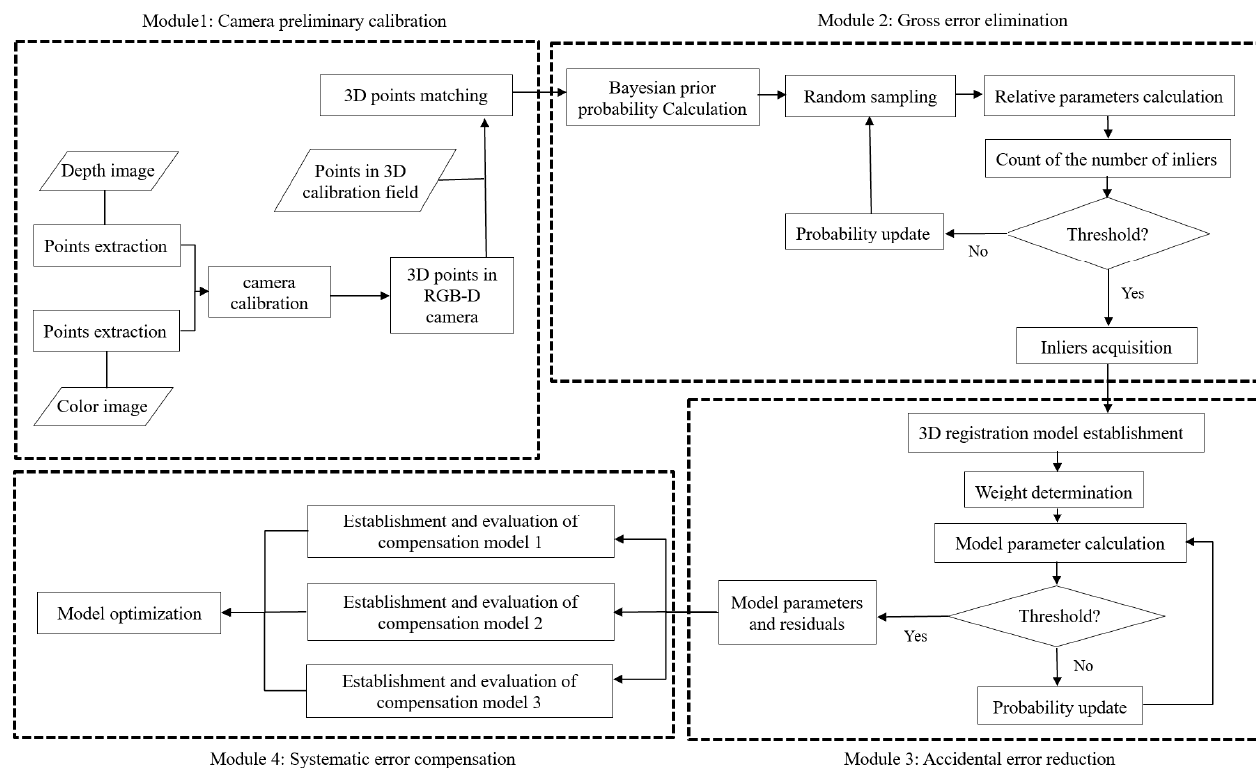
Figure 1. The algorithm flowchart of 3D systematic error compensation for RGB ‐ D cameras.